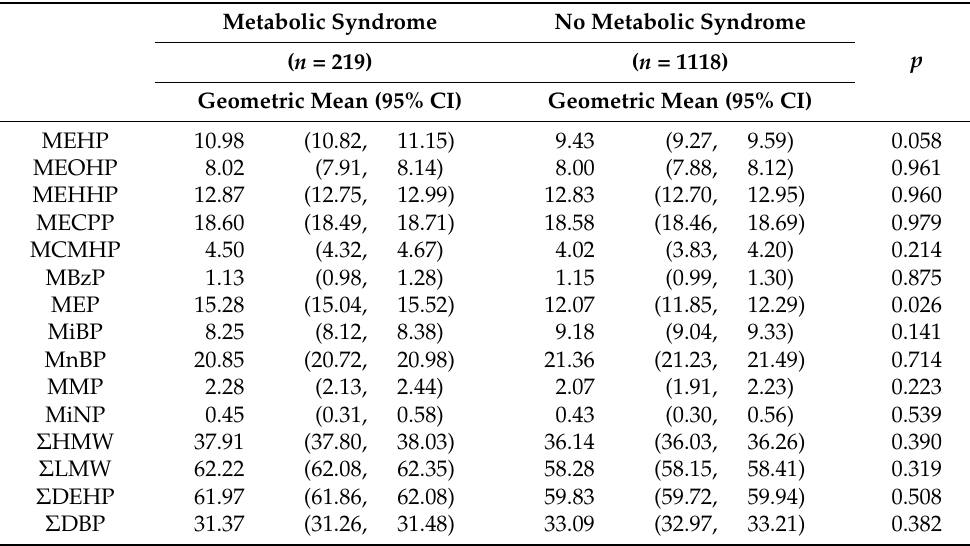
Table 2. Urinary phthalate metabolites by metabolic syndrome